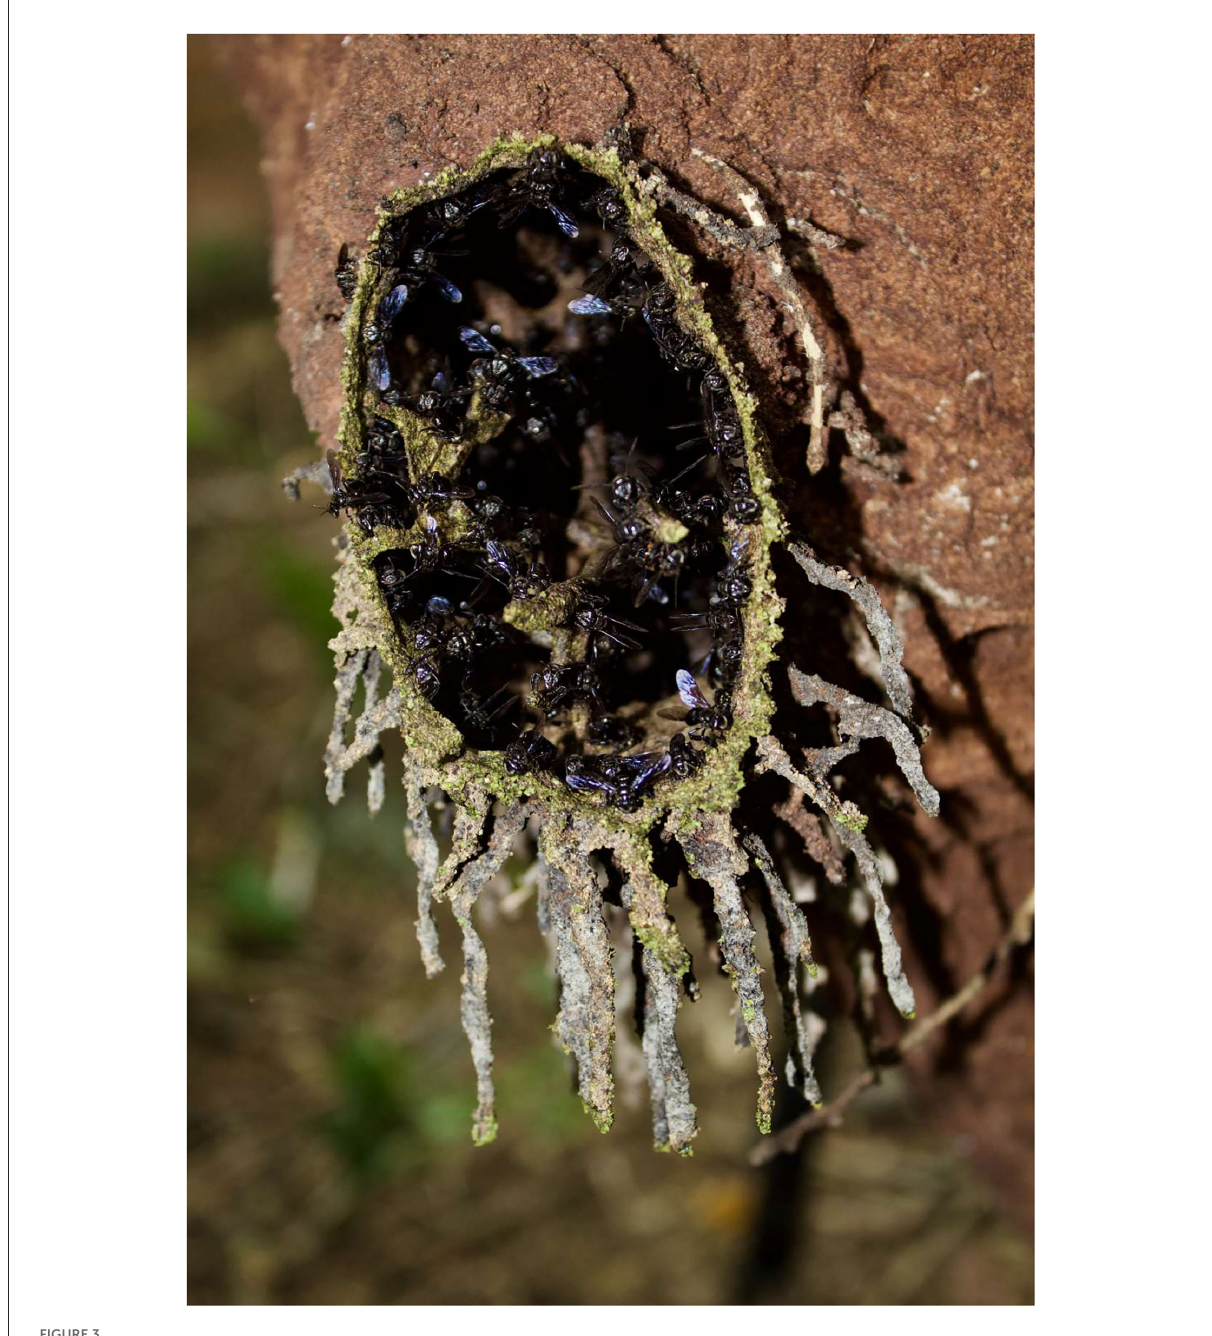
FIGURE3 Enredapelo o cuajacabeza (in local Spanish; Trigona corvina